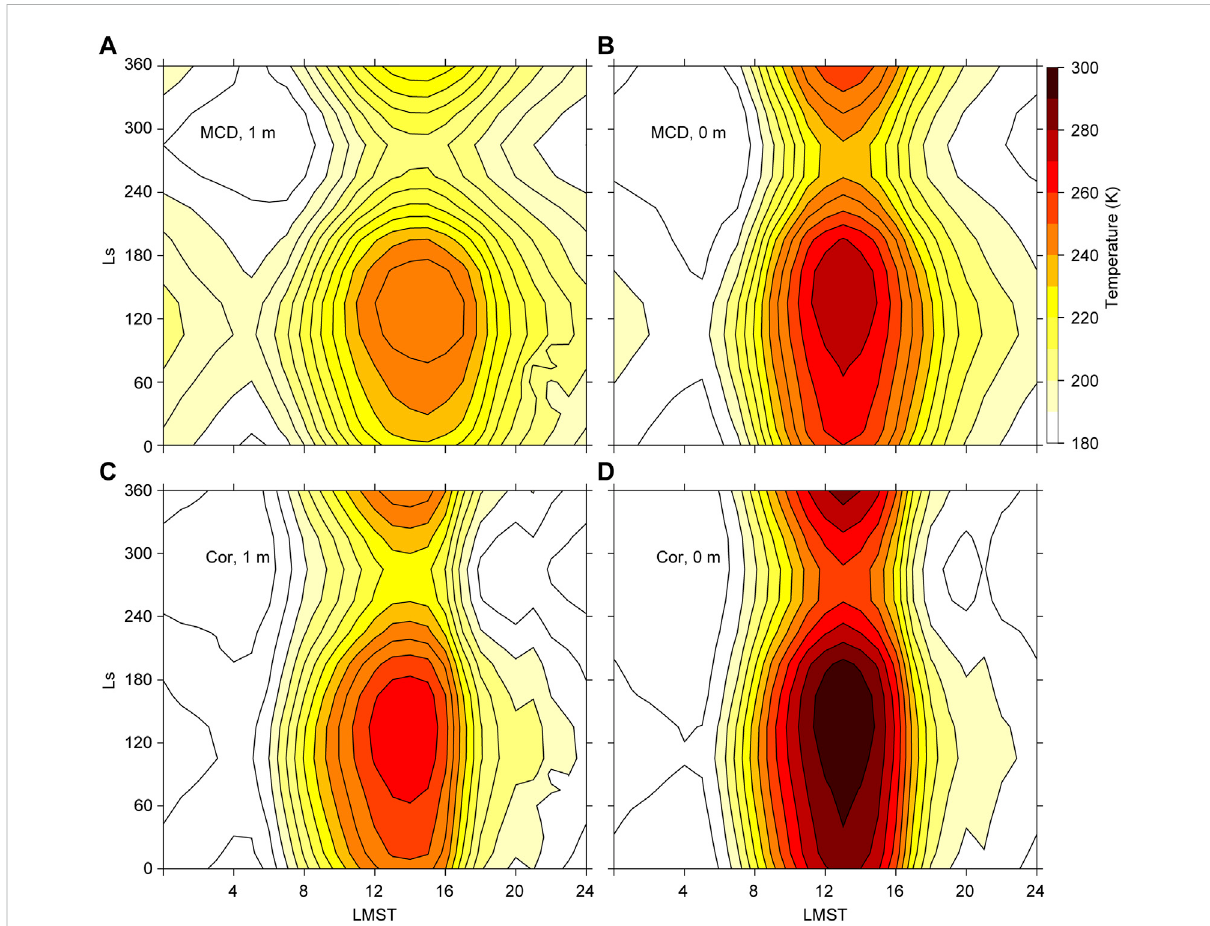
FIGURE 4 Temperature distribution through a whole year at the Zhurong landing site. (A) MCD modeled temperature with an altitude of 1 m (in the air); (B) MCD modeled temperature with analtitudeof0 m (ontheground); (C) InSight-basedcorrectedtemperature with an altitudeof1 m; (D) InSight- based corrected temperature with an altitude of 0